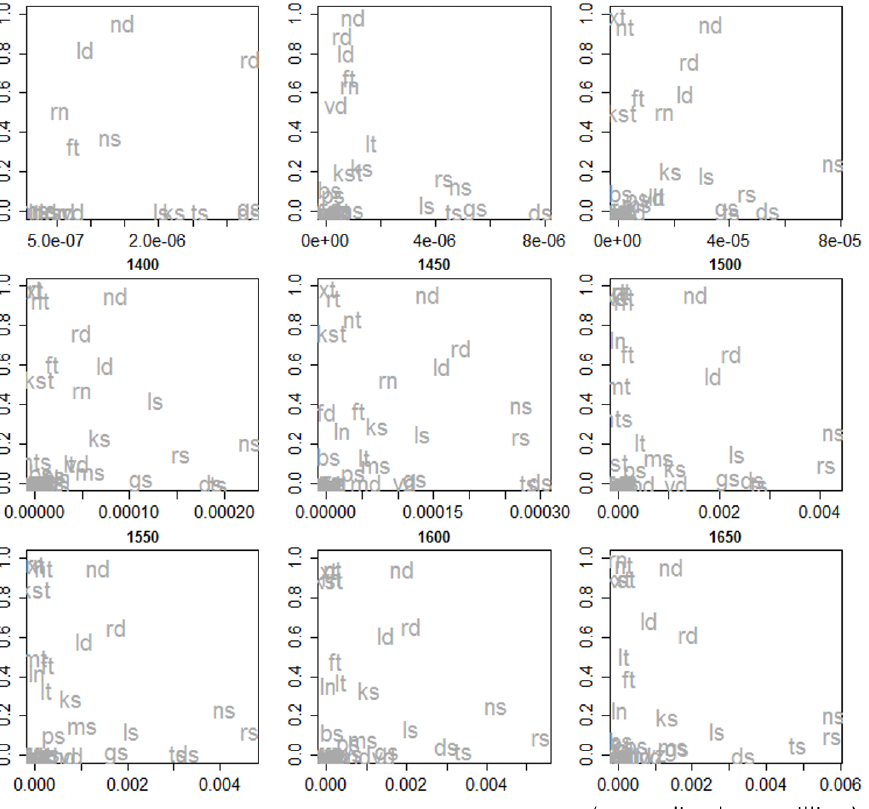
Figure 2. Labelled scatterplots showing the morphonotactic space in the nine semi-­‐ centuries from 1250 to 1700. Frequency scores were adjusted probablistically according to the spread of schwa-­‐loss and normalized per million with respect to the period-­‐wise